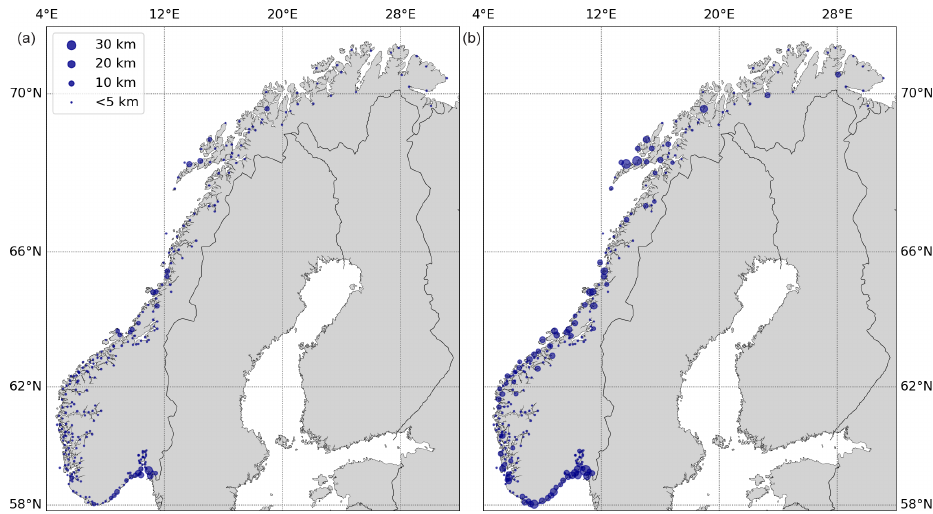
Figure 11. Affected roads due to a 200-year storm surge hazard at present (a) and for 2090 (b) . The radius of the bubbles are proportional to the length of exposed